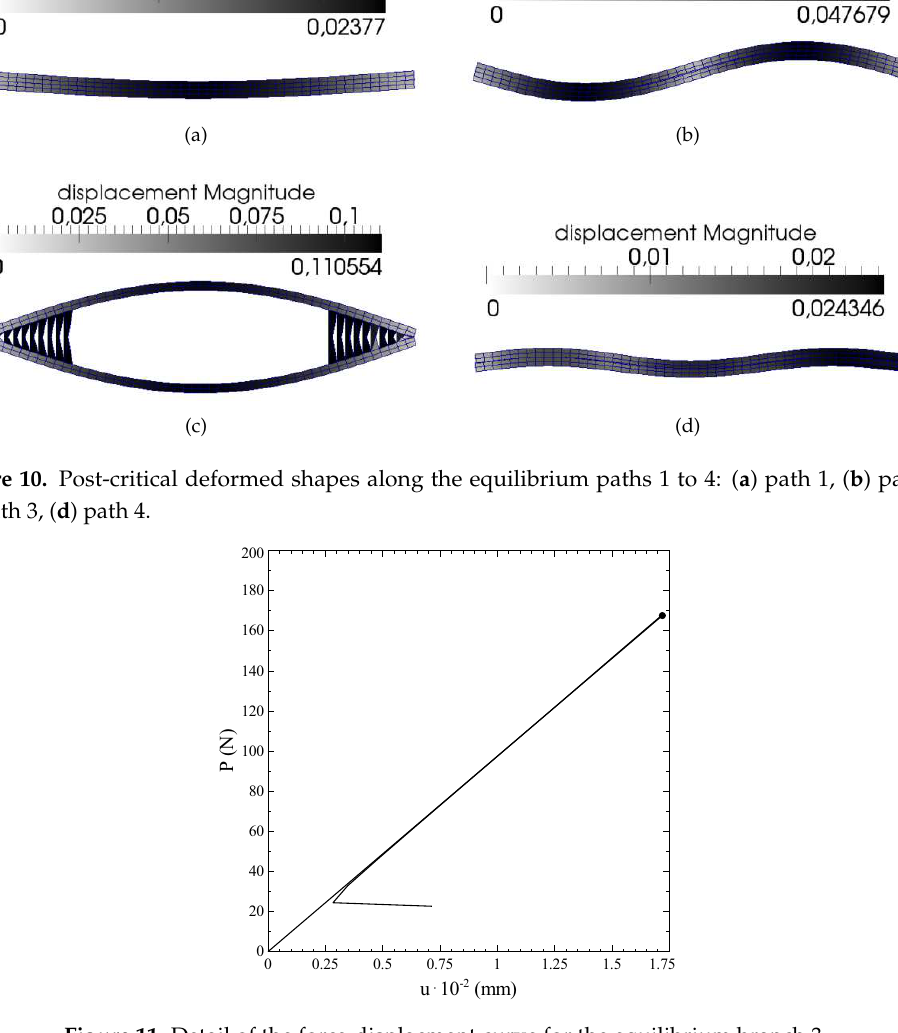
Figure 11. Detail of the force-displacment curve for the equilibrium branch